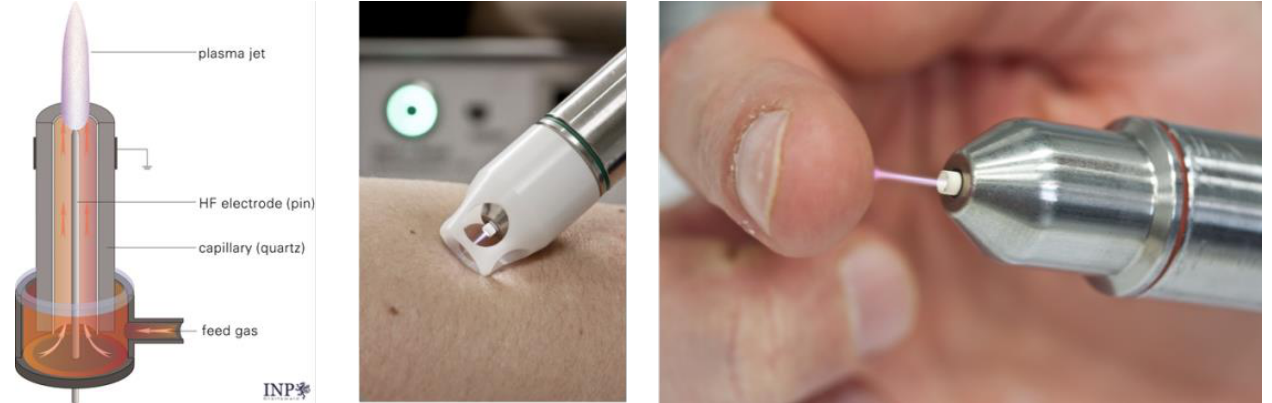
Figure 6. The approved (medical device class IIa) atmospheric pressure argon plasma jet kINPen MED. Current medical indications are decontamination and promotion of wound healing. ( Left ) Scheme of a prototype of the kINPen plasma jet with argon gas used as feed gas that is excited in a high-frequency electrode before driven out into the ambient air to generate reactive oxyxgen and nitrogen species. (Middle) kINPen MED equipped with a space. ( Right ) kINPen MED plasma jet connecting to the skin. Image reproduced from [93].